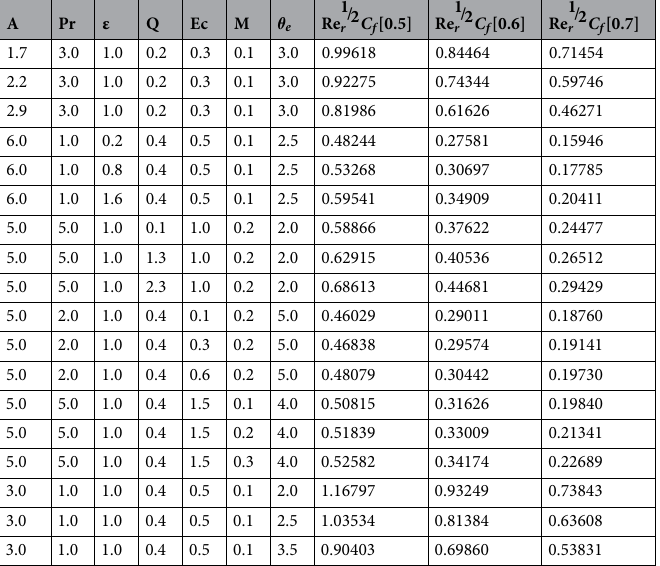
Table 2. Numerical values of Skin friction coefficient